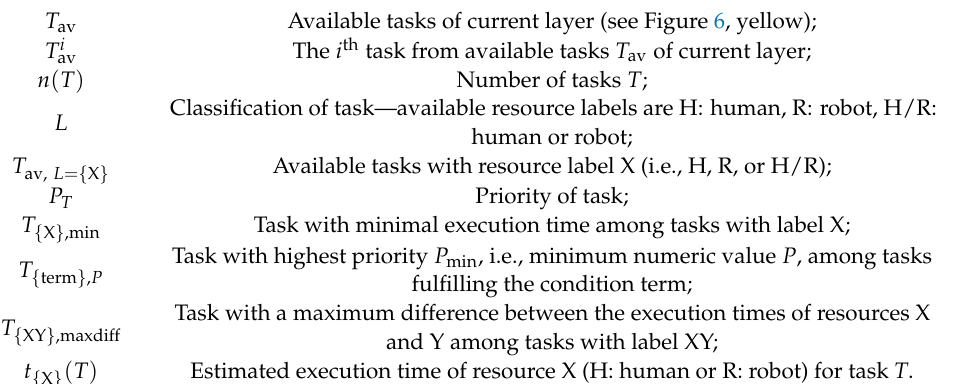
Figure 6. Schematic representation of a process flow during process execution with different states of tasks and task clusters highlighted.